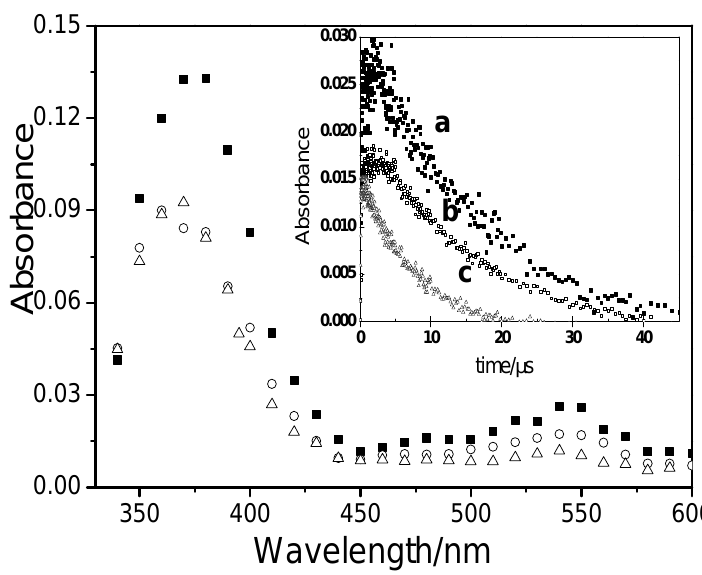
Figure 3. Transient absorption spectra of AQ recorded at 3 µ s after 355 nm laser excitation in RTIL/DMF mixed solution containing 1 · 10 -4 mol (cid:215) dm -3 AQ under N